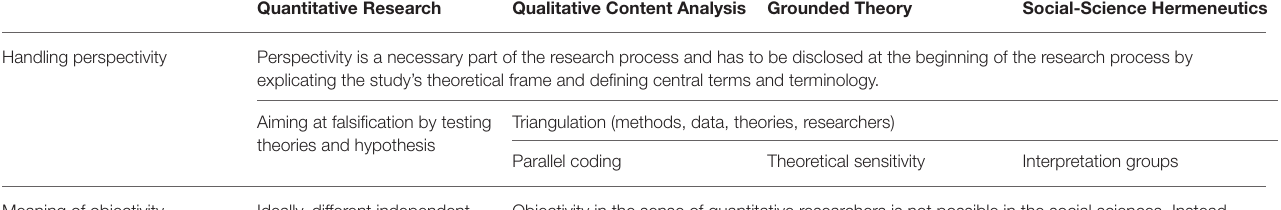
TABLE 1 | Commonalities and differences between research traditions concerning some aspects of the research process. Quantitative